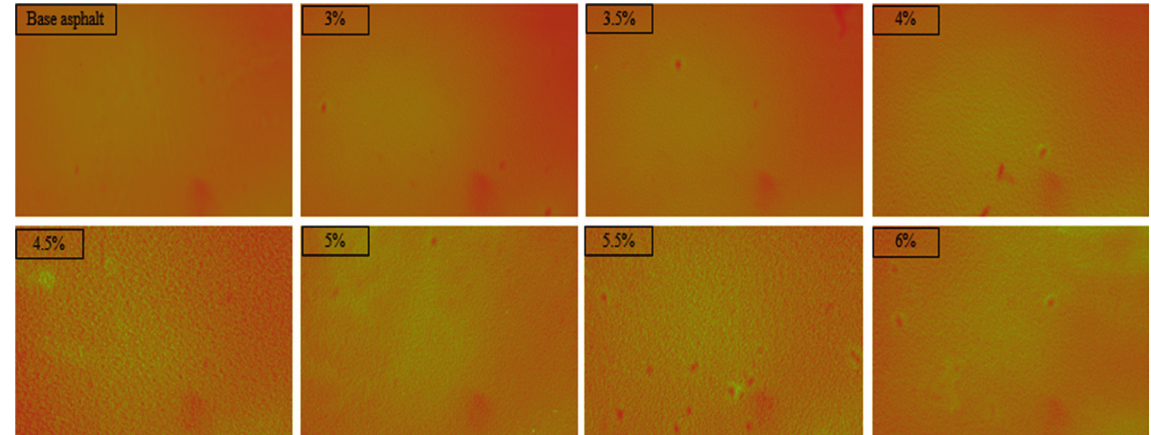
Figure 2: Fluorescent images of SBS modified asphalt with different SBS content.